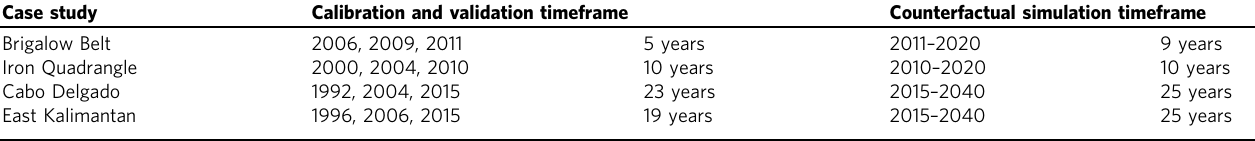
See Supplementary Methods 1 – 4 for information on individual case studies, datasets and